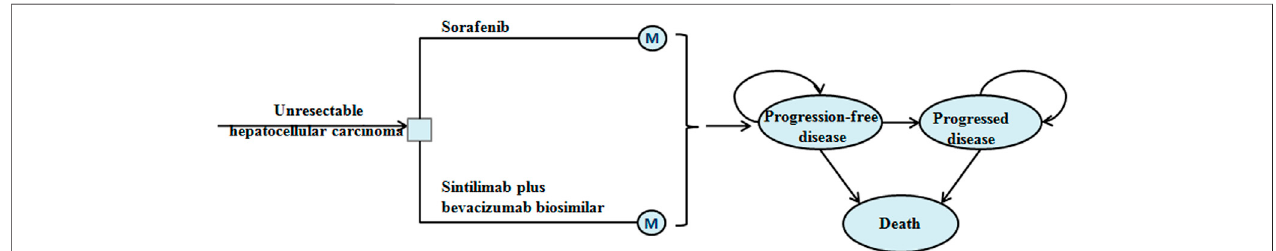
FIGURE 1 | Model structure of a Markov model combining the decision tree. M,